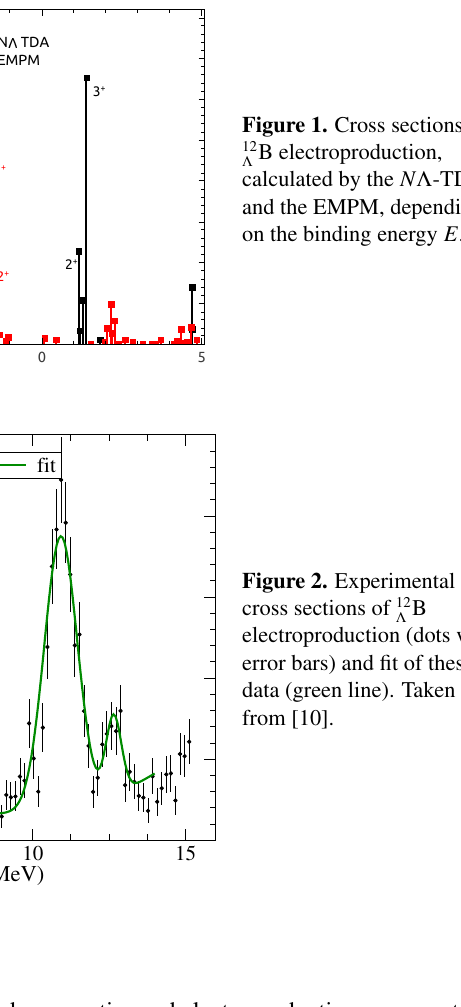
Figure 1. Cross sections of 12 Λ B electroproduction, calculated by the N Λ -TDA and the EMPM, depending on the binding energy E .